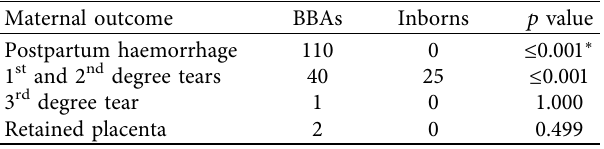
Table 4: Maternal outcomes. Maternal outcome